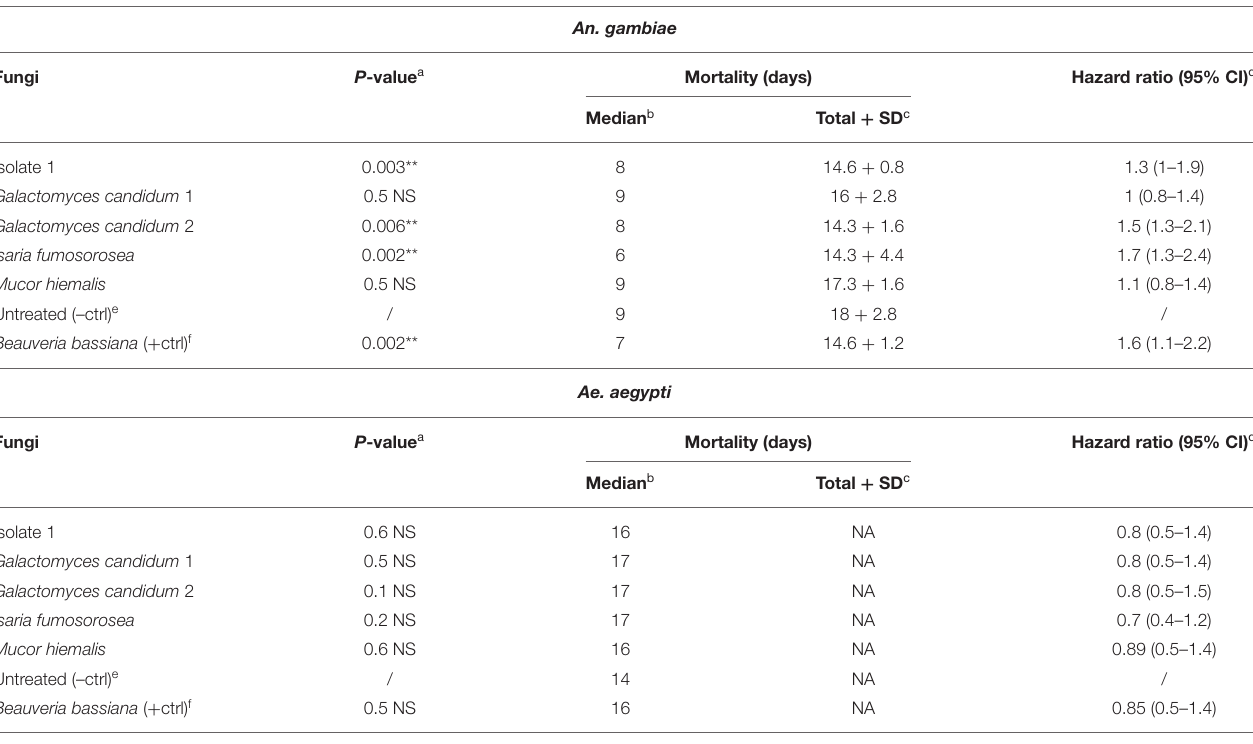
TABLE 4 | Mortality of An. gambiae and Ae. aegypti mosquitoes exposed to fungal metabolites by feeding assay.